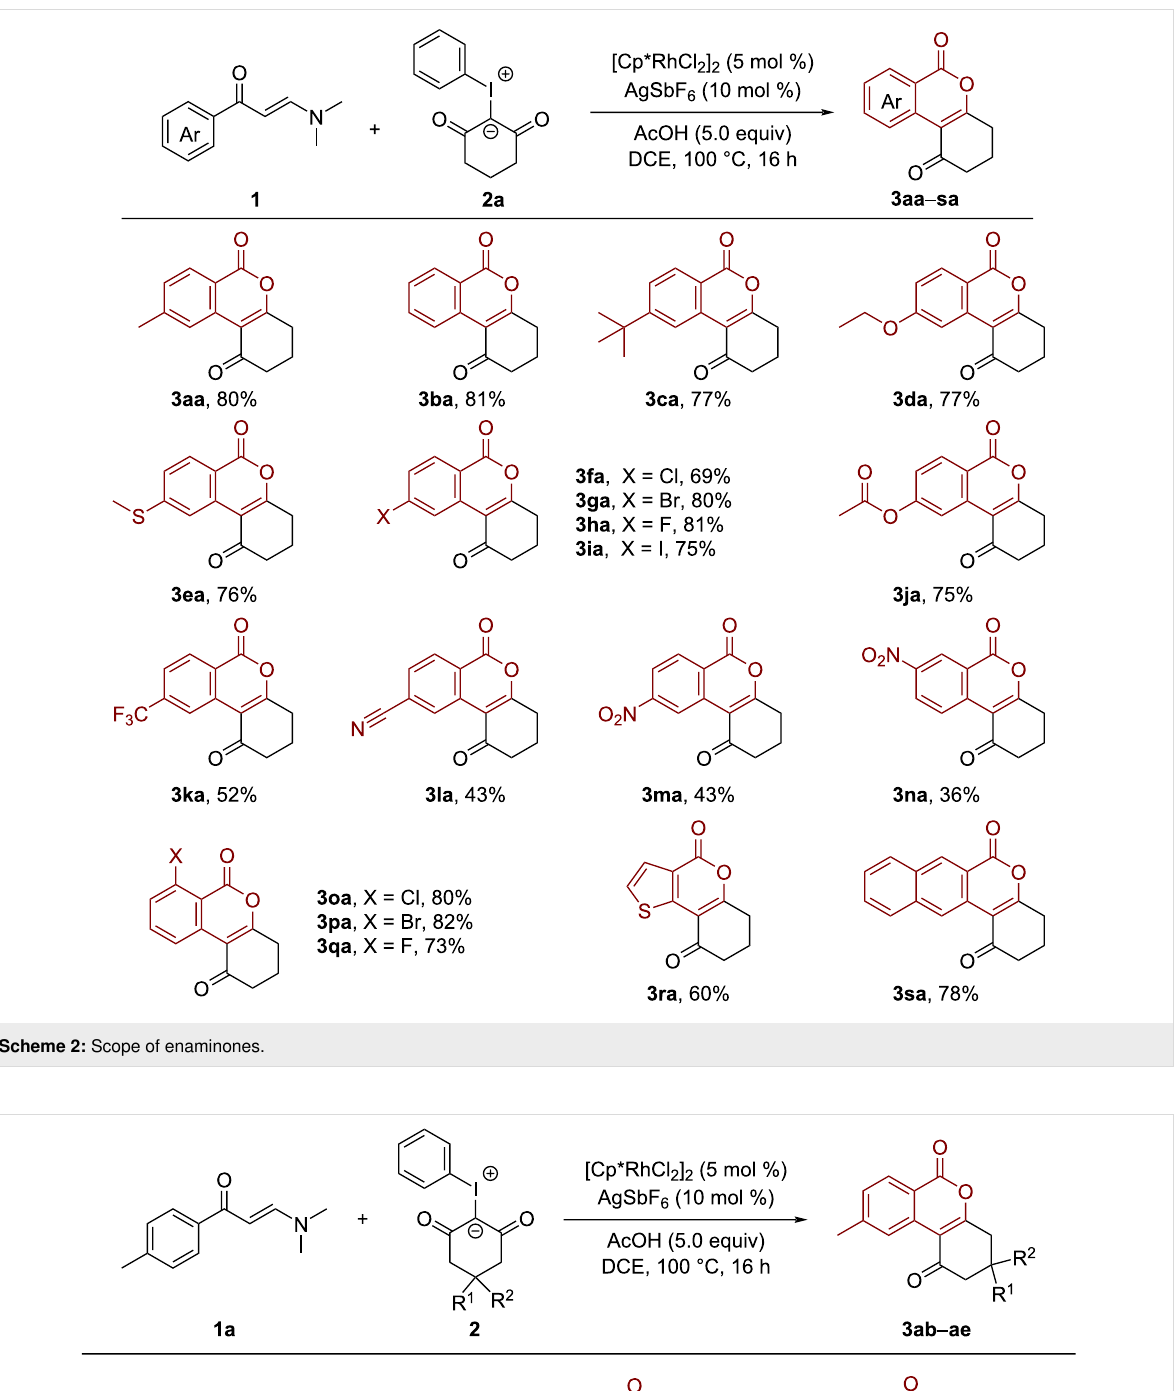
Scheme 3: Scope of iodonium